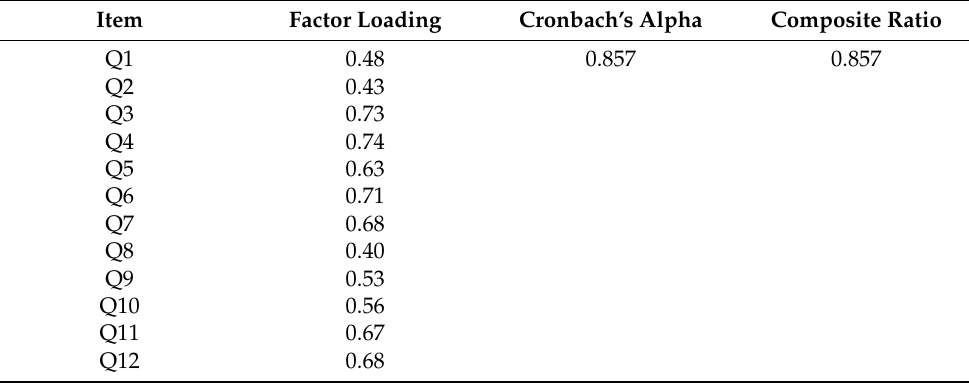
Table 4. Factor loading and internal consistency reliability of RAC-QM.